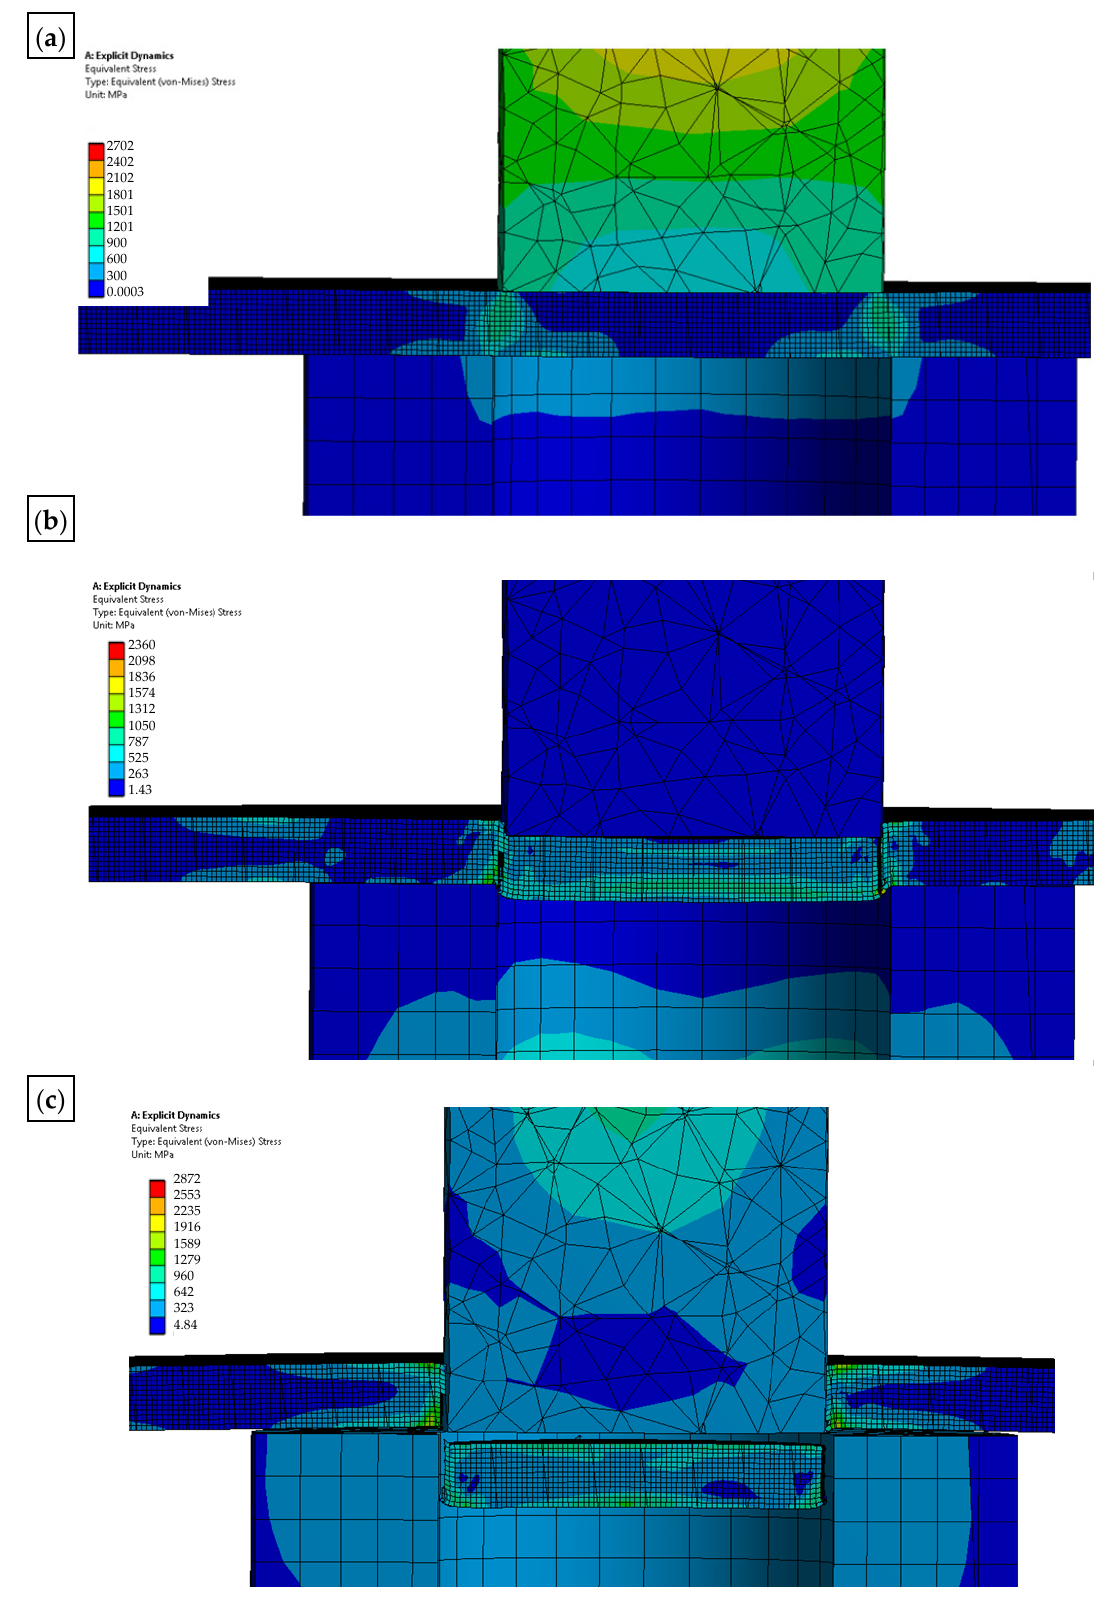
Figure 12. The state of reduced stresses in the tool and the punched sheet for various levels of advancement of the process: ( a ) for 3% advancement; ( b ) for 10% advancement; ( c ) for 80% advance- ment